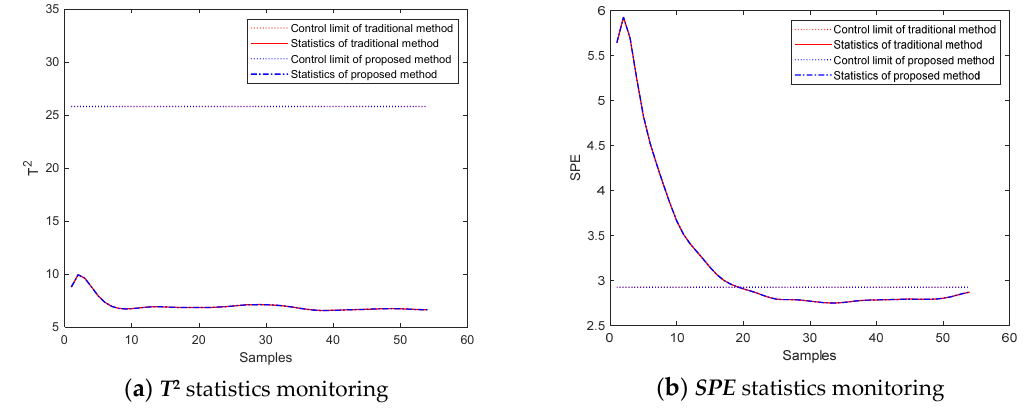
Figure 8. Single-mode online monitoring of injection phase of mode 1.